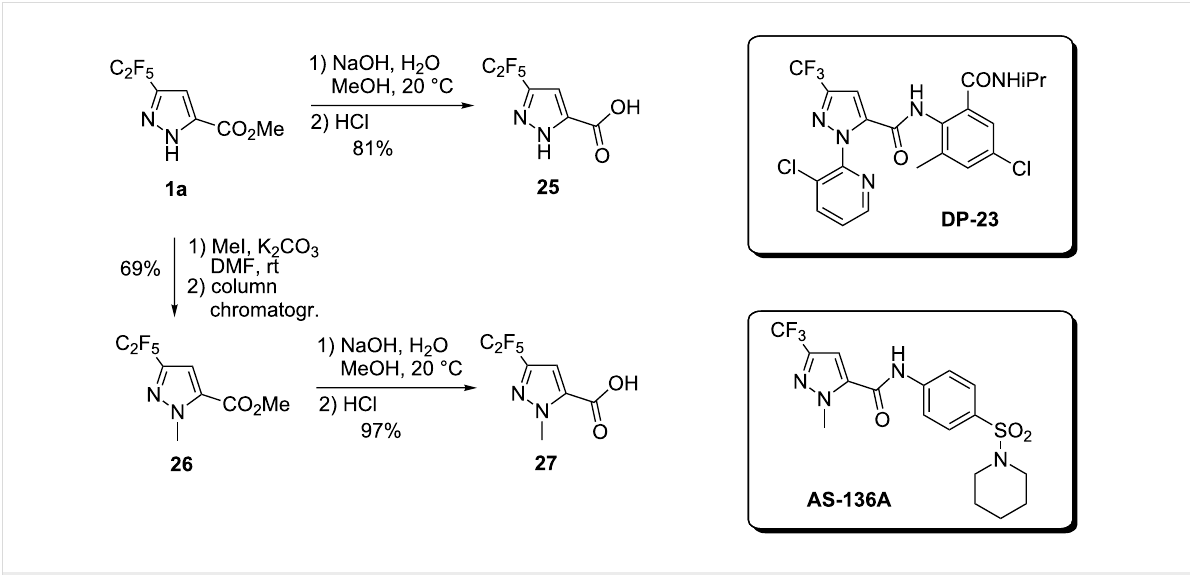
Scheme 3: Synthesis of C 2 F 5 -substituted acids 25 and 27 . In brackets are the known bioactive compounds DP-23 , AS-136A (CF 3 -analogues of 25 and 27 ).